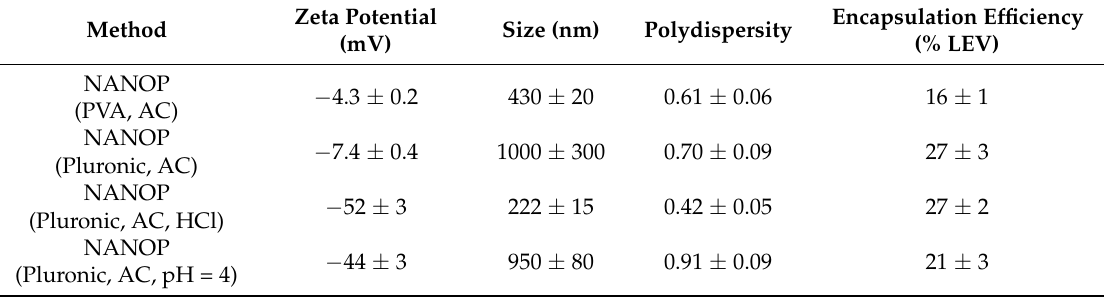
Table 1. Characterization of poly(lactic- co -glycolic acid) (PLGA) nanoparticles obtained by using nanoprecipitation (NANOP) methods (experimental results are expressed as the mean ± SD, n = 6 for DLS measurements and n = 3 for encapsulation efficiency (EE)).